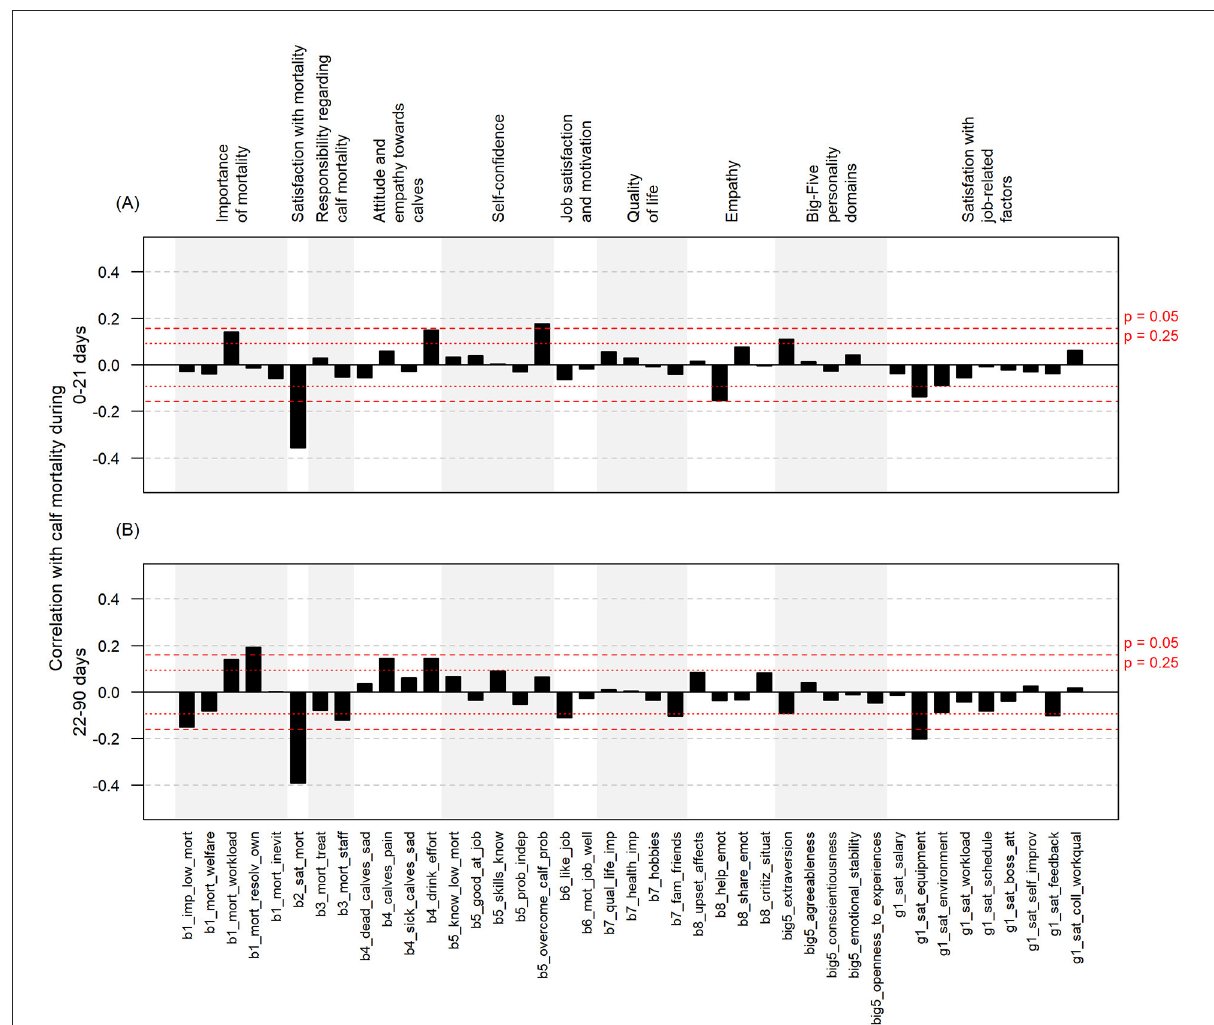
FIGURE2 Spearman correlations between calf care workers’ attitudes, opinions, personality domains, and satisfaction with job-related factors and yearly calf mortality risk (%) during the first 21 days of age (A) and 22–90 days of age (B) . Abbreviations are explained in Table